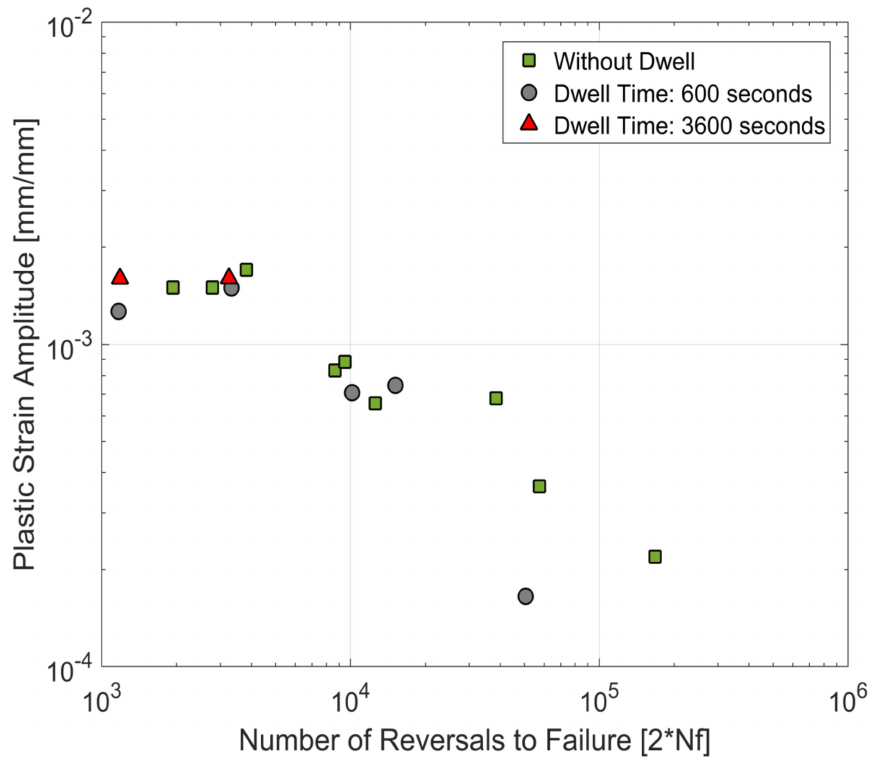
Figure 18. Strain life curves at 200 ◦ C—comparison of fatigue tests with and without compressive dwell times.